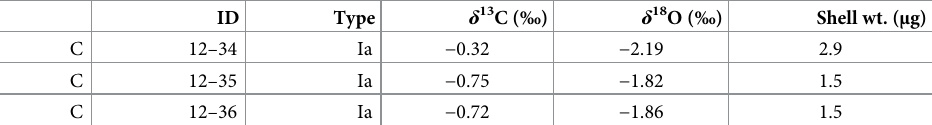
weight was calculated from the volume of CO 2 gas obtained during their reaction with phosphoric acid.